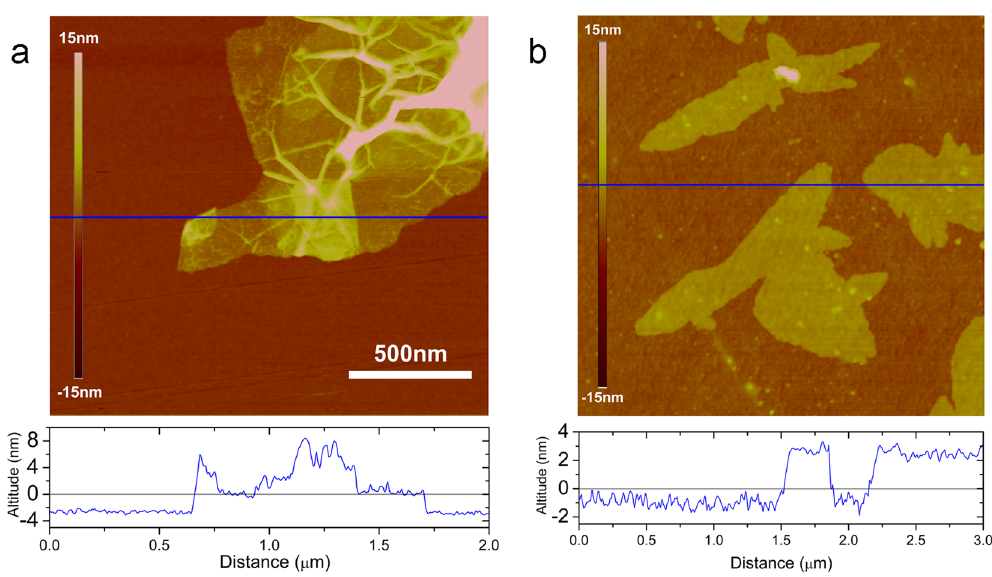
Figure 3. Representative AFM images and the cross sectional high profiles of ( a ) PreMG and ( b )